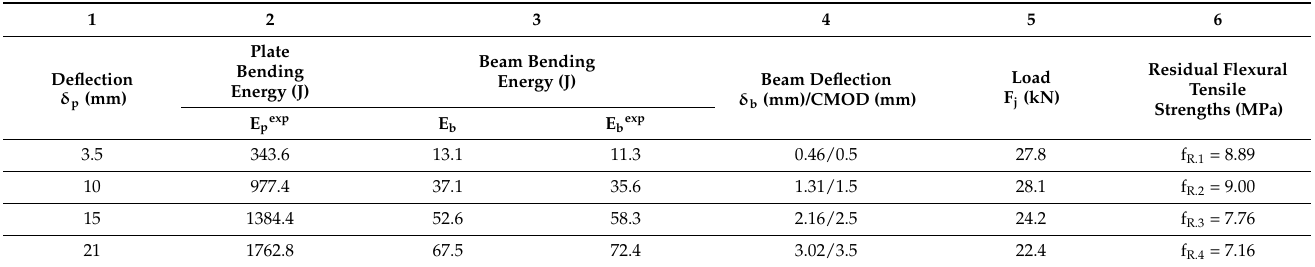
Table 5. The residual flexural tensile strengths (f R.j ) of the fiber composite calculated on the basis of the proposed